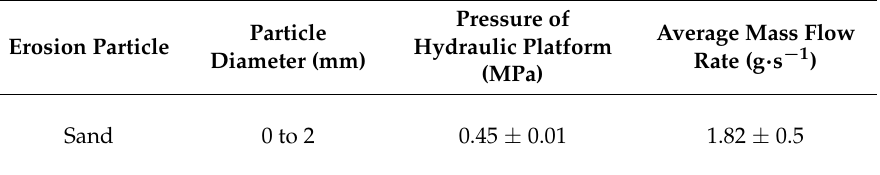
Table 4. Erosion wear experiment